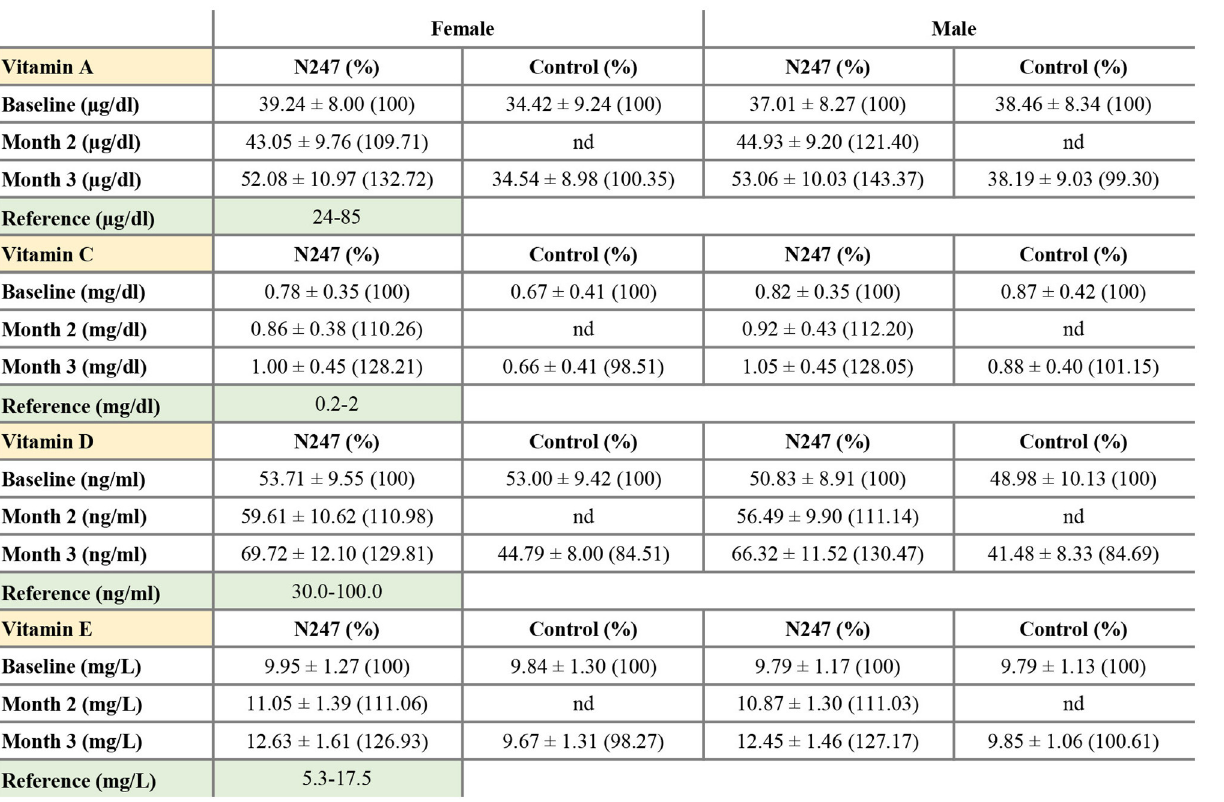
FIGURE 3 | Serum concentrations of vitamin A, C, D, and E. Values are mean